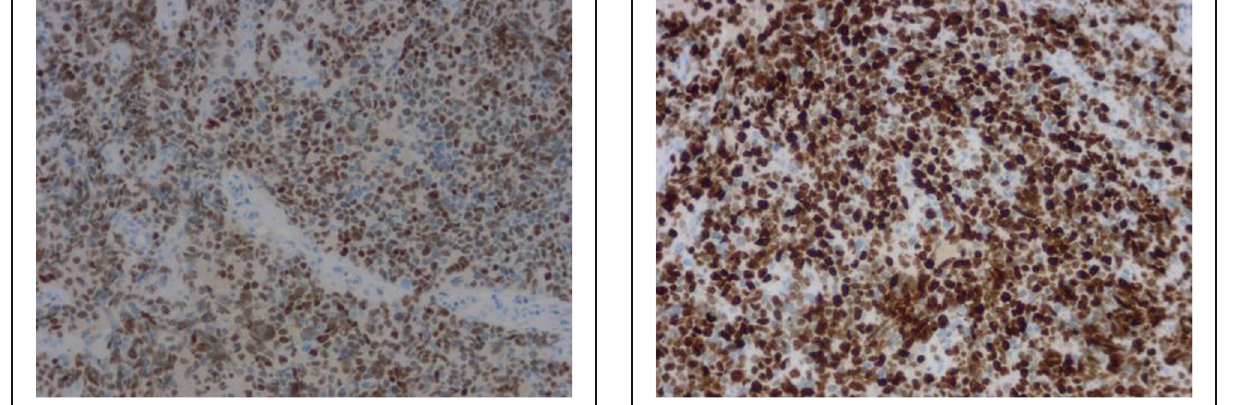
Fig. 8 En Vision method shows ≥ 90% ki-67-positive